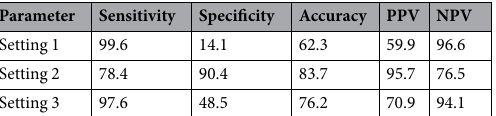
Table 4. Diagnostic performances of the three methods in the diagnosis of thyroid nodules. Setting 1 = TI- RADS; Setting 2 = scoring system; Setting 3 = the combined method of TI-RADS and scoring